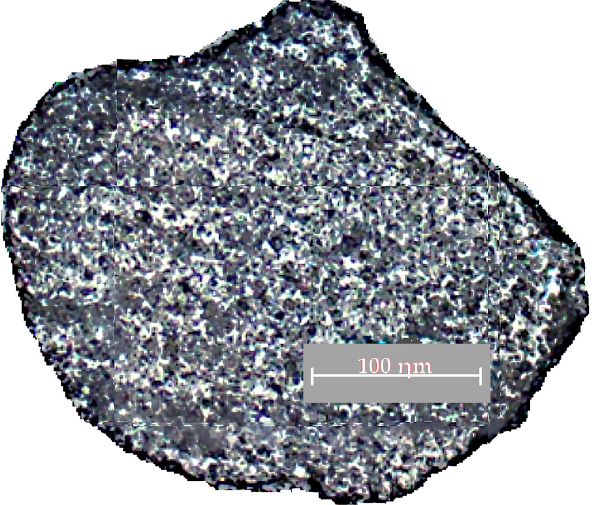
Figure 8. Photograph of a grain micro-specimen from the molding mixture containing the used liquid glass mixture, reclaimed product, liquid glass, and hardener.